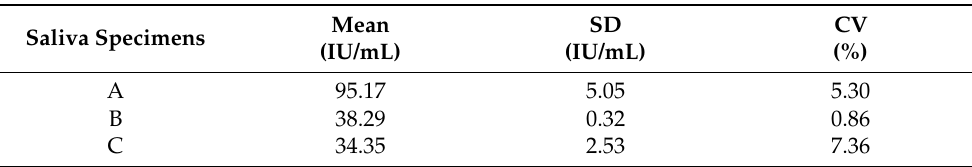
Table 2. Estimated concentration ( μ g) of bands of salivary alpha-amylase at 59 kDa and 56 kDa in the western blot (WB) and percentage (%) of difference before and after a glycoprotein depletion procedure. Saliva specimens were obtained from two pool saliva samples from three individuals who participated in a psychological stress test (the Trier Social Stress Test, TSST, specimen 1) just after the arithmetic task (T + 0), and in an exercise of CrossFit WODs (specimen 2) between rounds (T + 01), respectively. Pool samples were added at 3.0 μ g per lane. TSST